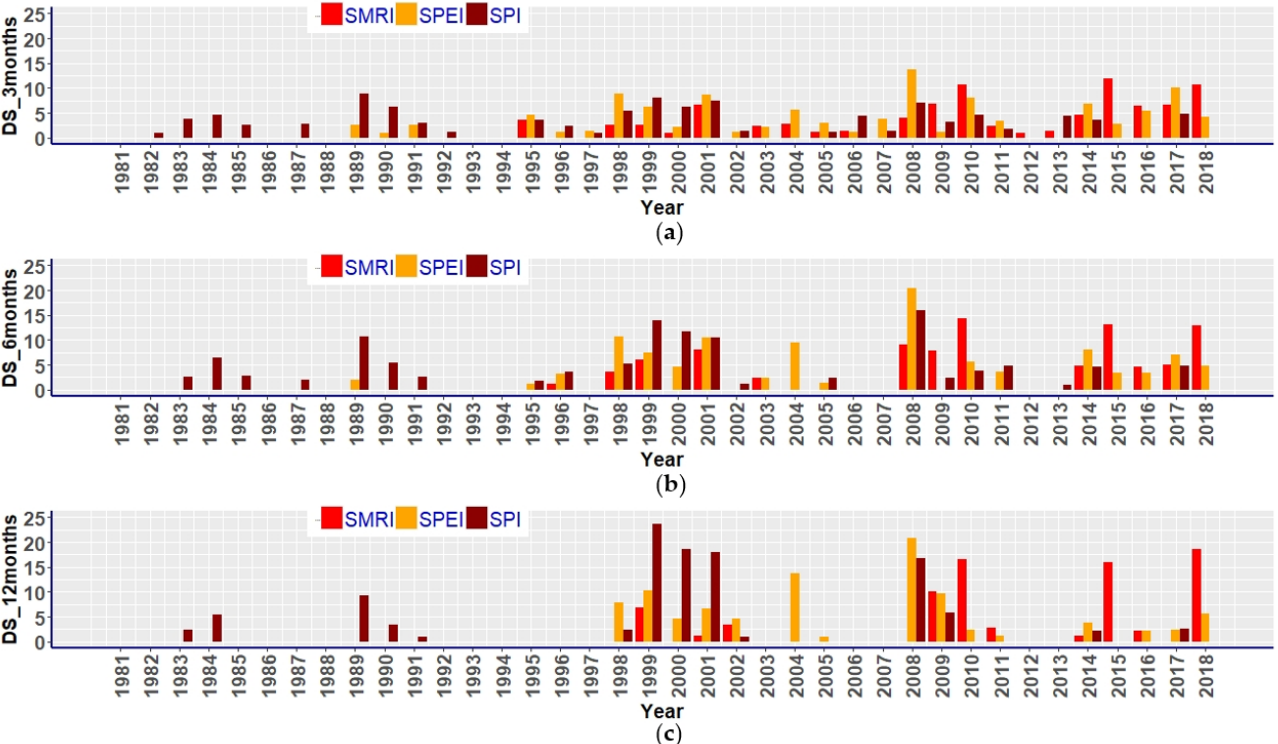
Figure 10. Drought Severity (DS) over ULB using SPI, SPEI and SMRI indices,1981 to 2018. ( a ) 3_months, ( b ) 6_months and ( c ) 12_ months.